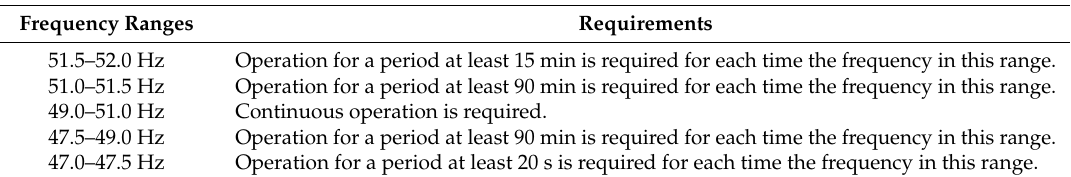
Figure 2. The requirement of the active power output from GB grid-connected generating units with the frequency change within the range of 47.0–50.5 Hz [10]. Table 5. The requirements of generating units regarding the GB grid frequency variations [10].